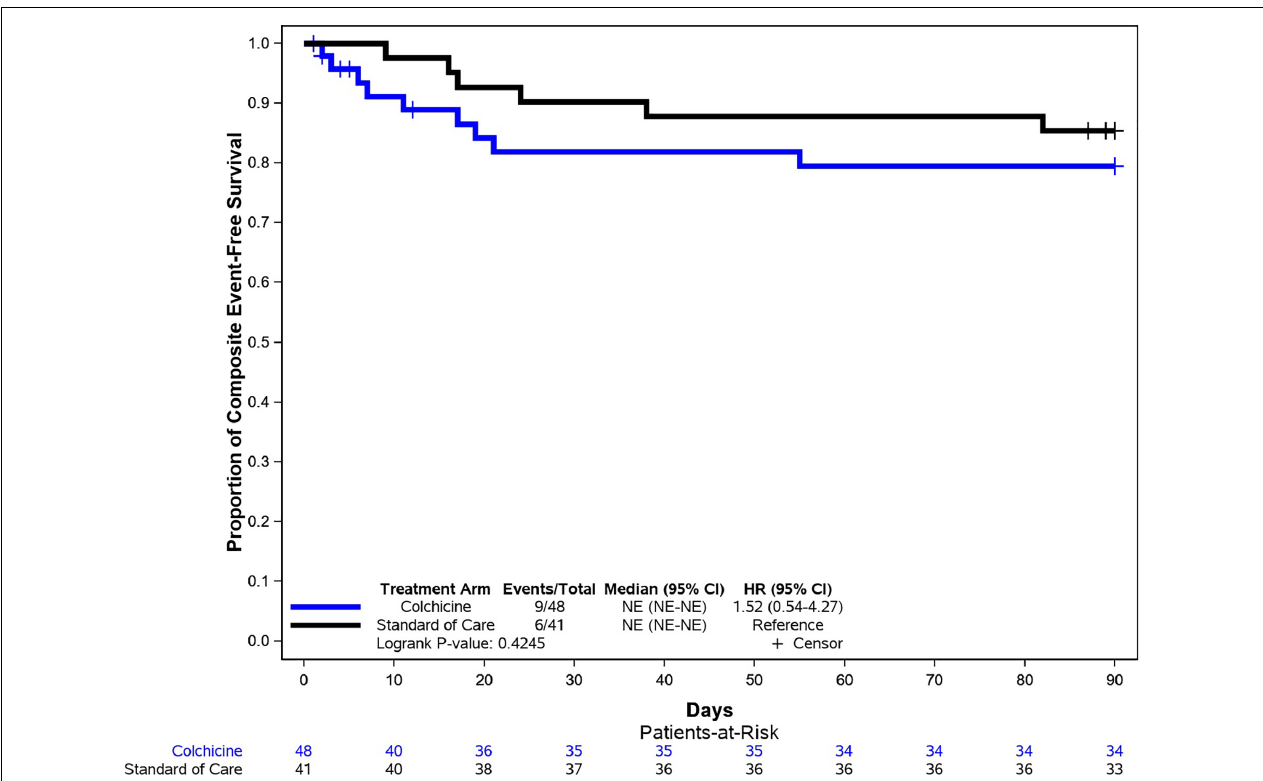
FIGURE 3 | Kaplan–Meier analysis for the primary endpoint. Kaplan–Meier analysis demonstrated similar rates of event-free survival (composite of all-cause mortality, need for mechanical ventilation, or need for mechanical circulatory support) among patients in the colchicine and control arms.